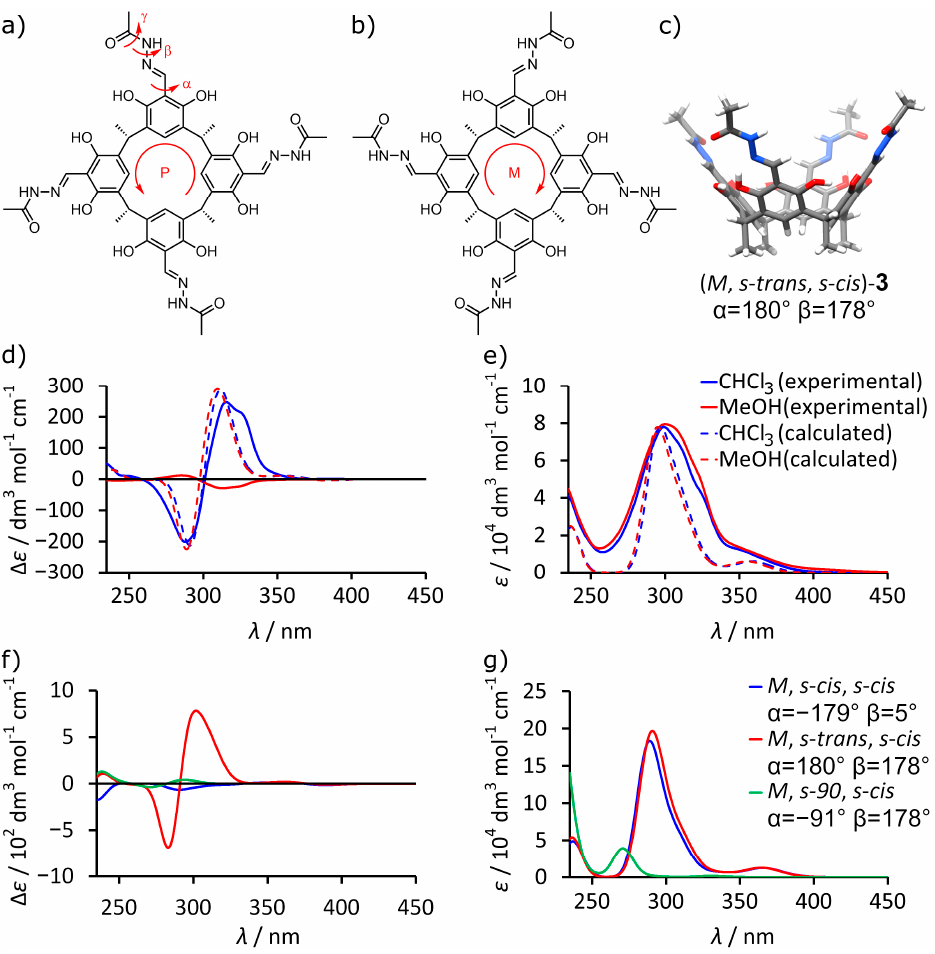
Figure 3. Comparison of experimental spectra of L - 1 and theoretical spectra of 3 in CHCl 3 and MeOH: ( a – c ) models used for estimation of the influence of conformational effects (coordinates available in Supplementary Materials); ( d ) experimental and theoretical ECD and ( e ) UV spectra; ( f ) calculated ECD and ( g ) UV spectra for different conformations of 3 . The intensities of experimental spectra were calculated for the concentration of cavitand L- 1 . Theoretical spectra were calculated using TD DFT B3LYP/6-31G(d,p), starting from the geometry retrieved from the crystal structure; their intensities (ECD and UV) were normalized at intensity of experimental UV spectra.